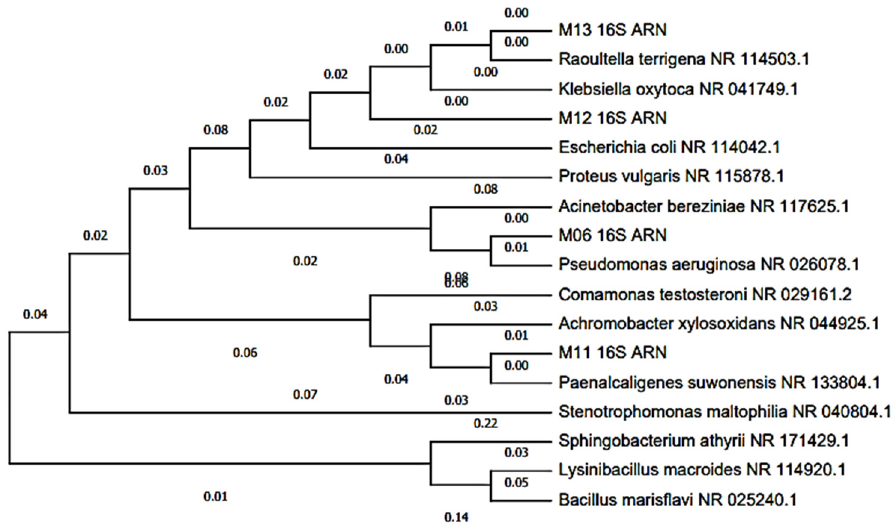
Figure 6. Dendrogram of bacterial clusters isolated from the MFC anode plate with banana sub- strate.